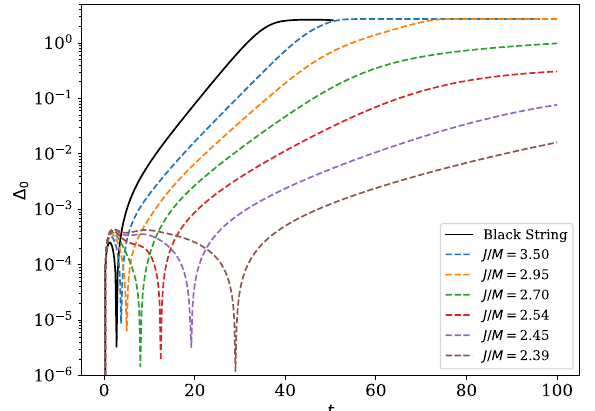
Figure 14 . Deformation of the black bars at their center, as a function of time, for several values of J/M . Perturbations of all unstable bars ( J/M > 4 / √ 3) present a phase of exponential growth given by the linear growth rate W of the dominant mode. The zero mode with n as the growth rate vanishes at the threshold of the instability, W ( J/M = 4 / √ 3) = 0. Also, for very long bars, W ( J/M ) 1 / 4, recovering the dominant growth rate of a black string. → ∞ →